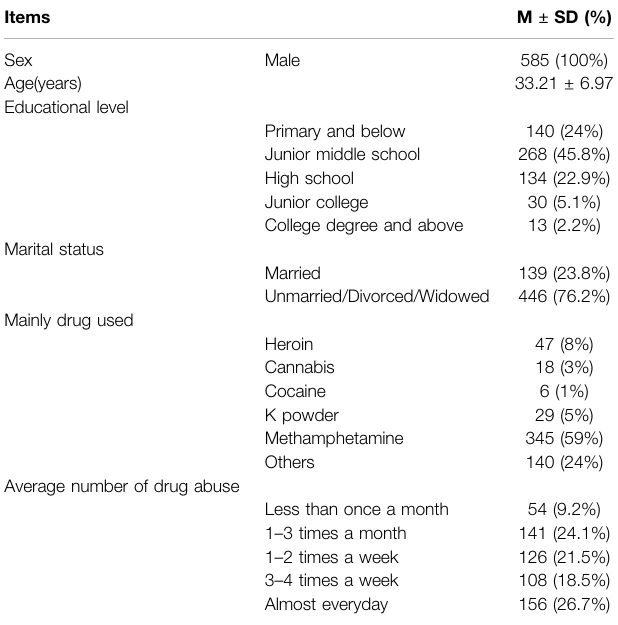
TABLE 1 | Demographic information of substance abusers ( N (cid:1) 585).